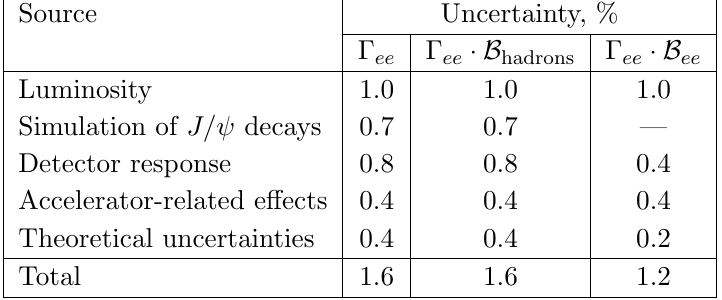
Figure 7 . Comparison of (cid:0) ee ( J= ) and (cid:0)( J= ) measured in the most precise experiments and (cid:0) ee ( J= ) predictions from lattice QCD calculations. The (cid:0)( J= ) value from the BESIII experiment was calculated from [14] using the world-average lepton branching fraction [6]. The gray band corresponds to the world-average value with allowance for the uncertainty in it.